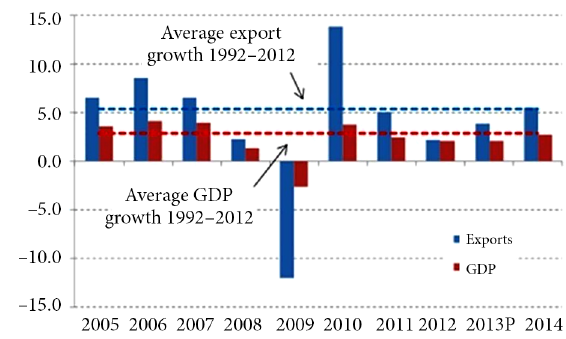
Figure 1. Volume of world trade in goods 2005–2014 (source: World Trade Organization (2014)